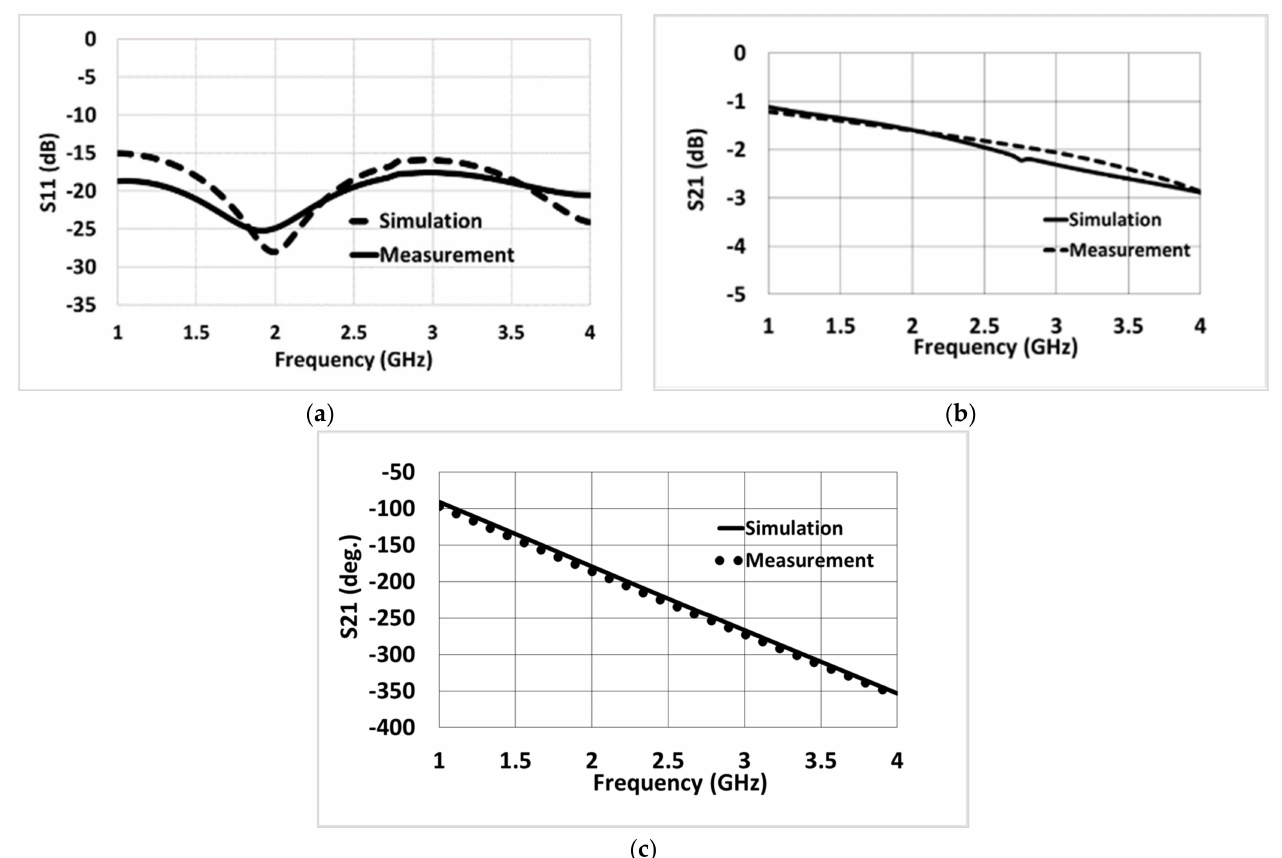
Figure 4. Comparison of simulated and measured S-parameters of the 50 Ω TL made of Electrifi and NinjaFlex filaments: ( a ) S 11 magnitude; ( b ) S 21 magnitude; ( c ) S 21 phase vs. frequency